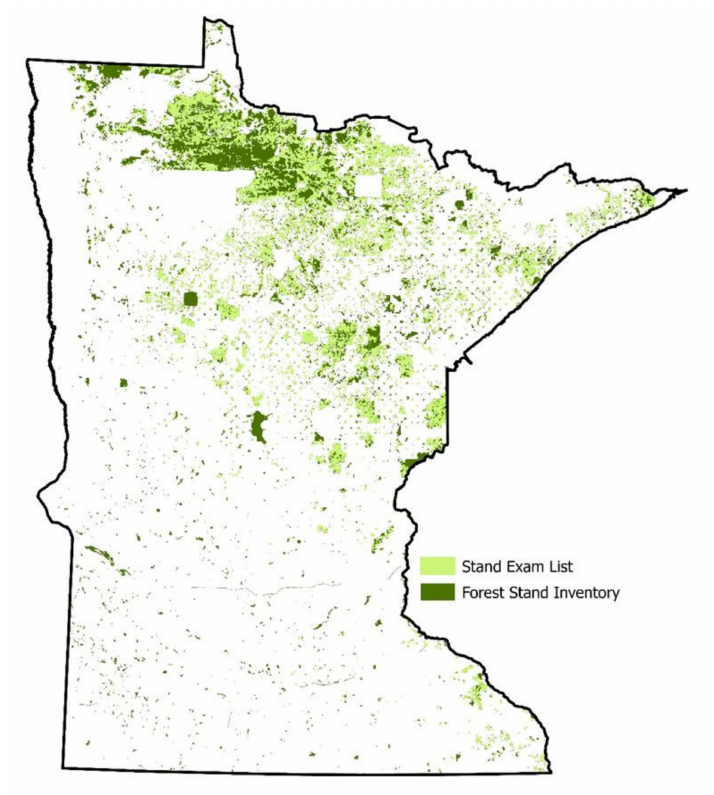
Figure 1. Forest stand inventory (FSI) stands from the Minnesota Department of Resources. Stand Exam List (SEL) stands are a subset of FSI stands scheduled for examination for potential manage- ment